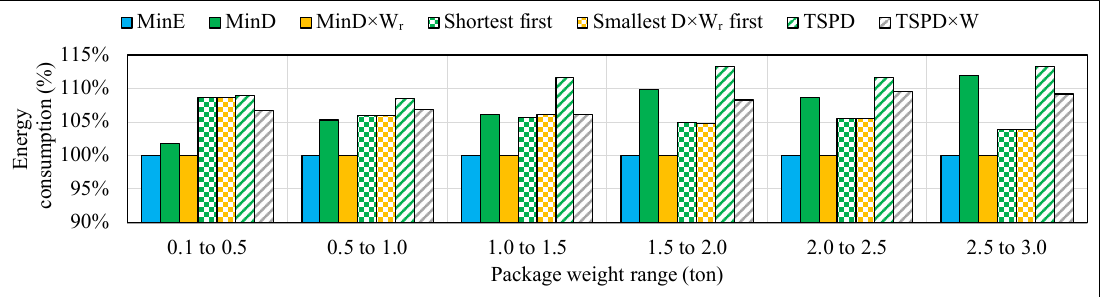
Figure 8. Energy consumption by package weight